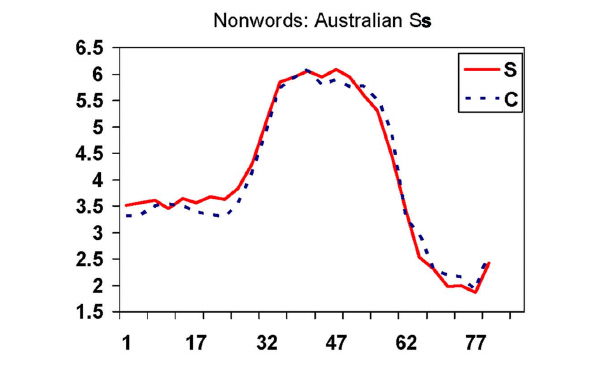
FIGURE 5 | Orthographically biased non-words rated by native English-speaking listeners: mean rated goodness as /s/ on a 7-step scale (vertical axis) as a function of step on the 81-step continuum from /z/ at left through /s/ to / ∫ / at right (horizontal axis), separately for non-words with S-consistent real-word analogs (solid line) and C-consistent real-word analogs (dashed line).